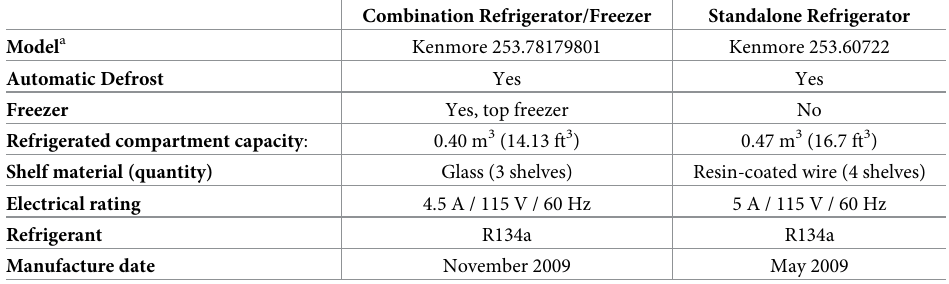
Table 1. Domestic test refrigerator